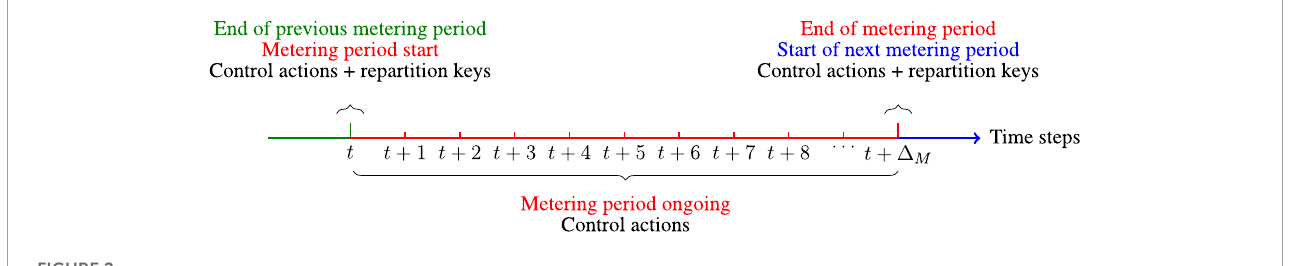
FIGURE 2 Illustration of the time discretization strategy of the decision process described in the problem statement starting from a given time step t and ending at t + Δ M , where tmod Δ M = 0. These two discrete time steps both corresponds to the end of a metering